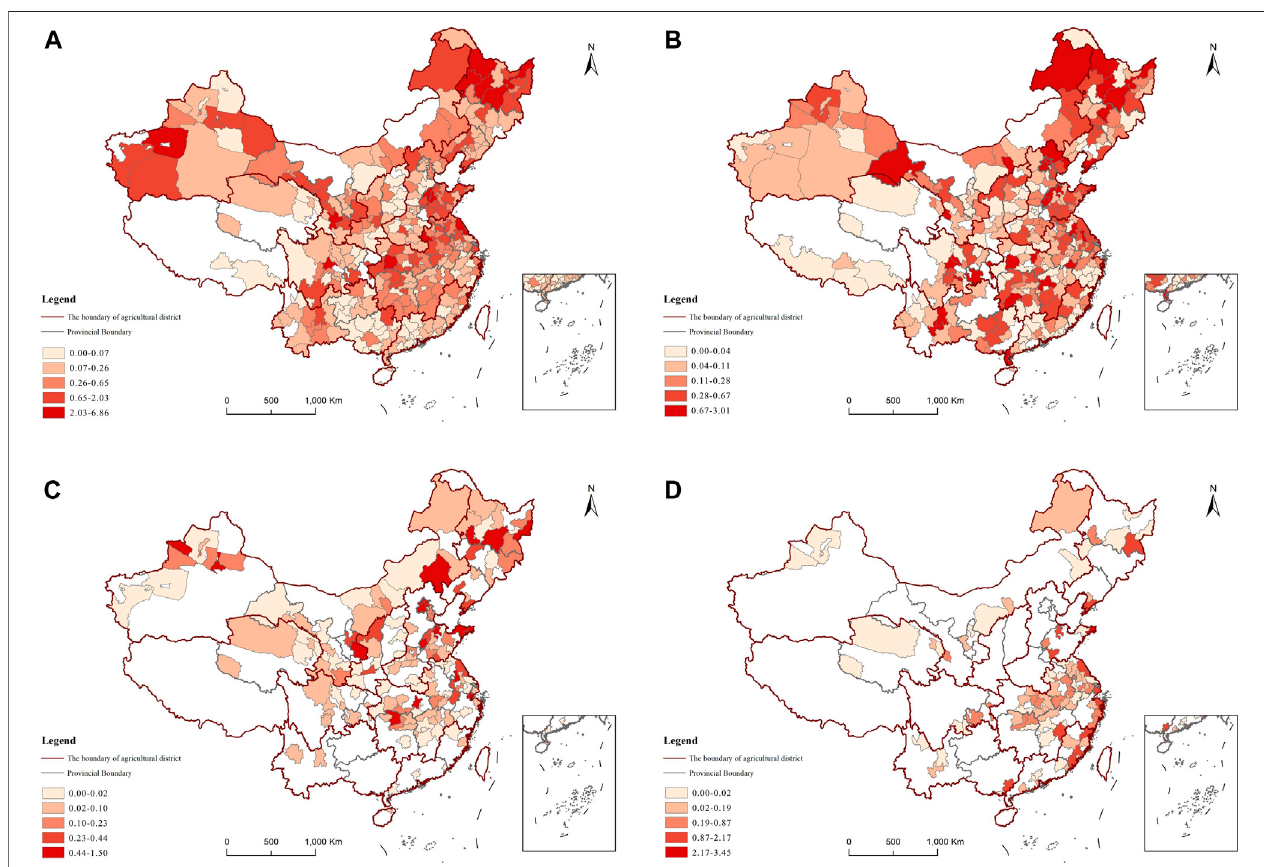
FIGURE5| Spatialconcentrationfeatures ofthefoursectors: (A) plant productenterprises, (B) processenterprises, (C) livestockand poultryproductenterprises, and (D) fi shery product enterprises.